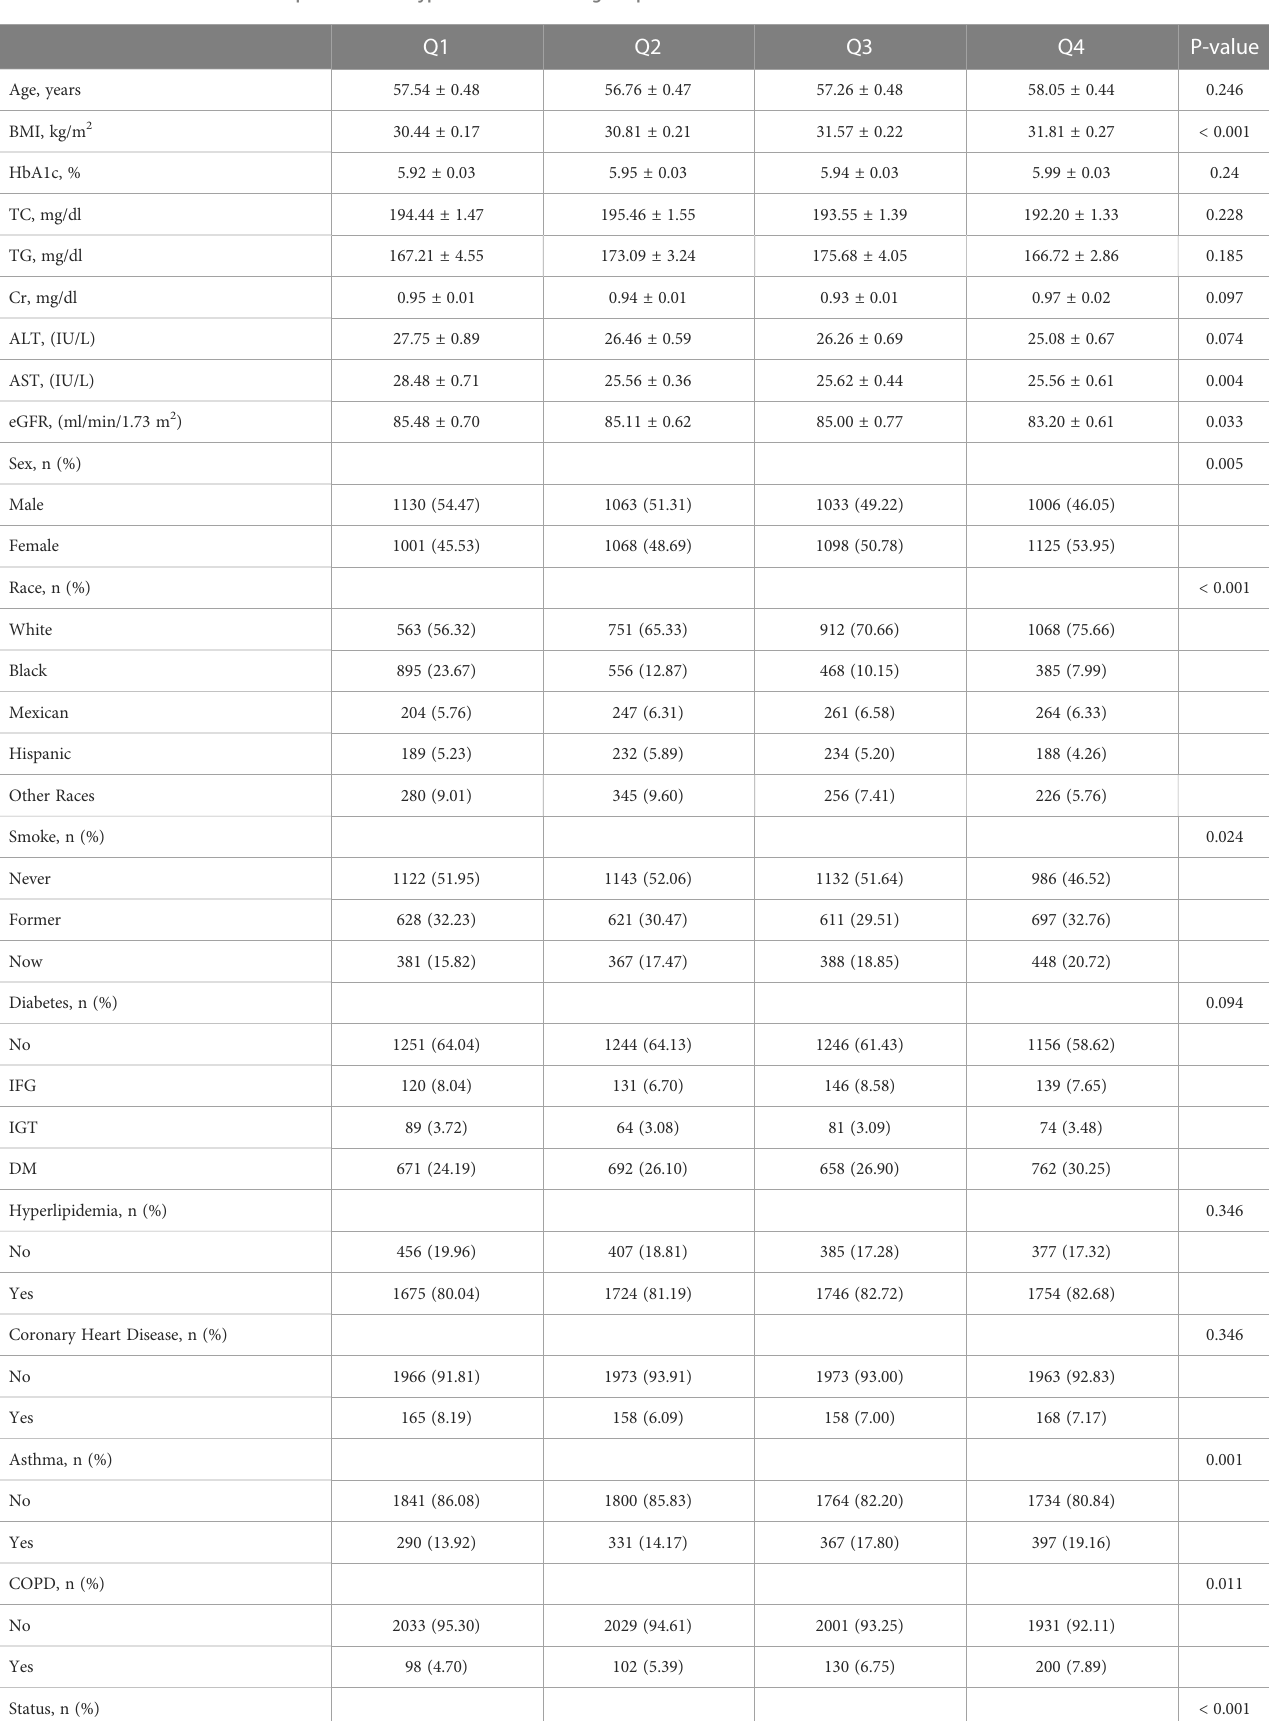
TABLE 1 Baseline characteristics of patients with hypertension according to quartiles of lnSII in NHANES 2011 –